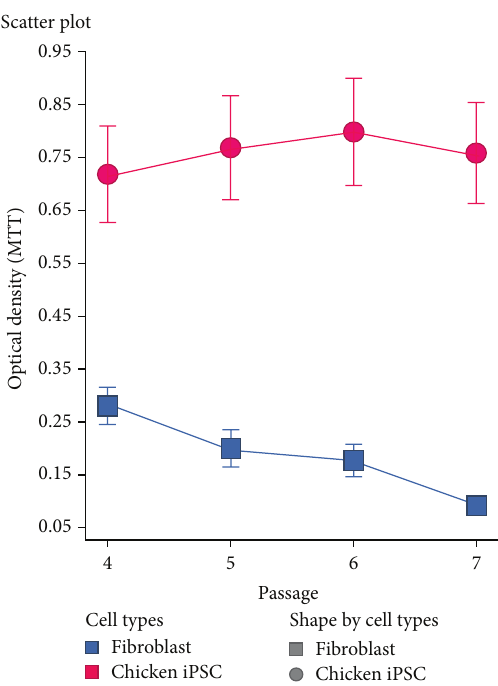
Figure4:MTTassayofchickeniPSC-likecellscomparedtochicken embryonic fibroblasts. Fibroblasts decreased significantly in optical density as they were passaged over time, while chicken iPSC- like cells grown in modified 2i+ retained their metabolic potential regardless of passage